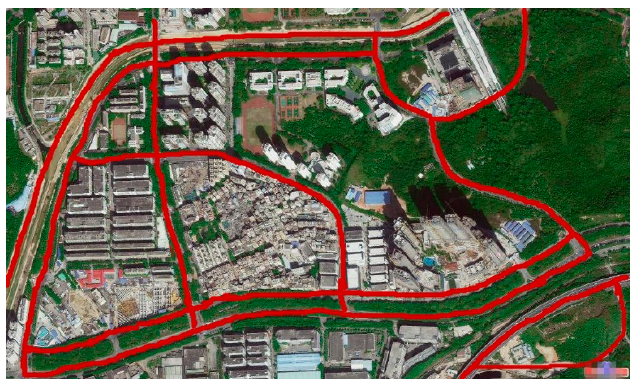
Figure 2. Driving map depicts a part of the covered routes in the data collection process. Table 1. Information about cars used in the experiment.